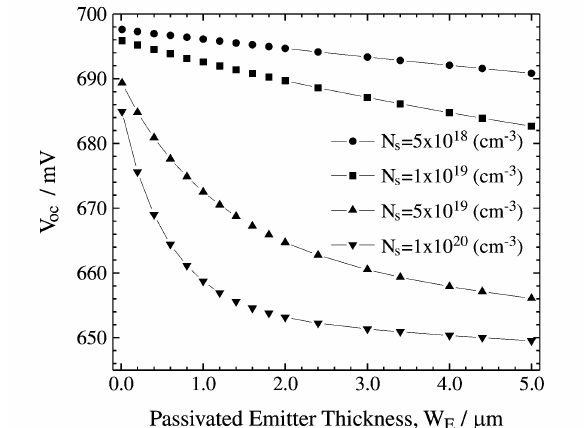
Figure 5. Solar cell open-circuit voltage (V oc ) vs. emitter thickness (W E ) with different doping levels (metal grid shadowing factor F m = 3%).